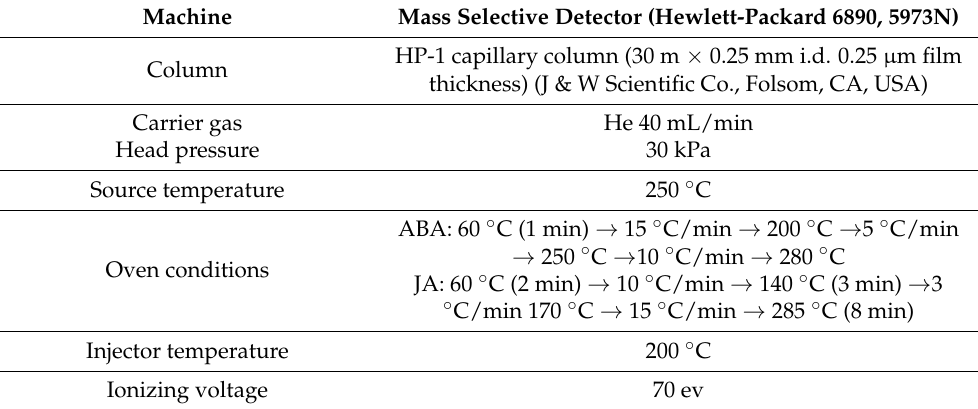
Table 1. GC/MS–SIM settings for the estimation of the ABA and